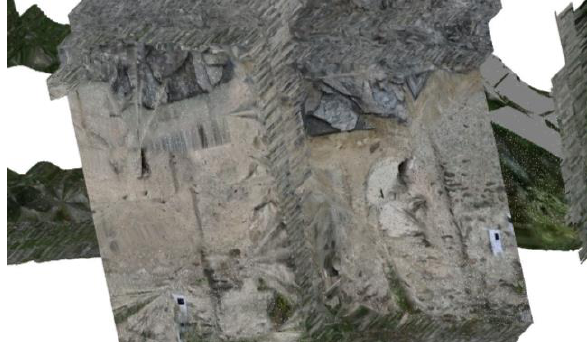
Figure 17. The error in the generation of the point cloud in Context Capture